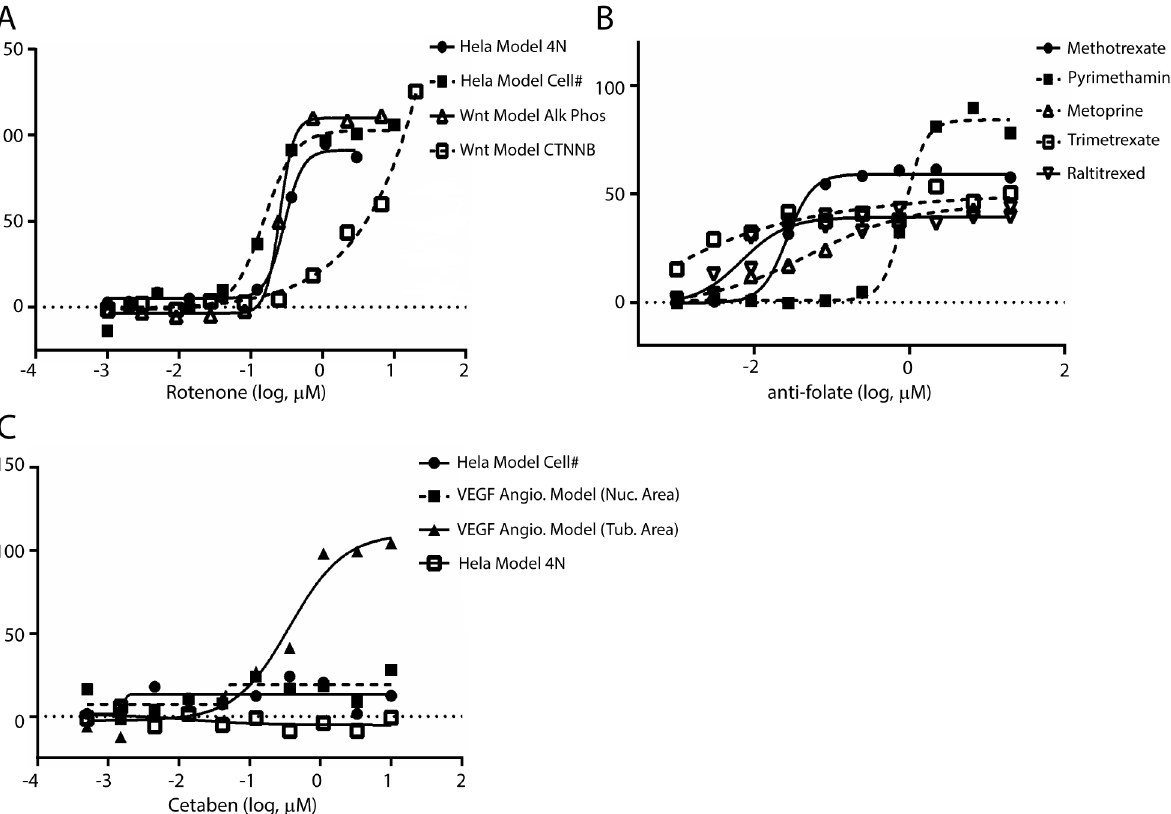
Fig 3. Novel activities for selected approved drugs versus specified assay modules. A. Potentiation of Wnt pathway signaling by rotenone. Included are the outcomes in a multilineage potential C2C12 cell line as judged by β -catenin translocation ( □ ) and alkaline phosphatase activity ( Δ ); selectivity of the Wnt response vs. cell cycle effects is assessed by comparison to % inhibition of cell count ( & ) and % stimulation of 4N DNA content ( ● ) as determined via propidium iodide staining in HeLa cells. B. Potentiation of Wnt pathway signaling by antifolates methotrexate ( ● ), pyrimethamine ( & ), metoprine (Bw 197U; Δ ), trimetrexate ( □ ) and raltitrexed ( r ) in the Wnt potentiation module. C. In vitro anti-angiogenic activity of cetaben. Inhibition of tube area in ECFC as measured via CD31 staining ( ▲ ) in the absence of ECFC/ADSC cytoxicity as assessed via Hoechst staining ( & ); selectivity of endothelial response vs. cell cycle effects is assessed by comparison to % inhibition of cell count ( ● ) and % stimulation of 4N DNA content ( □ ) as determined via propidium iodide staining in HeLa